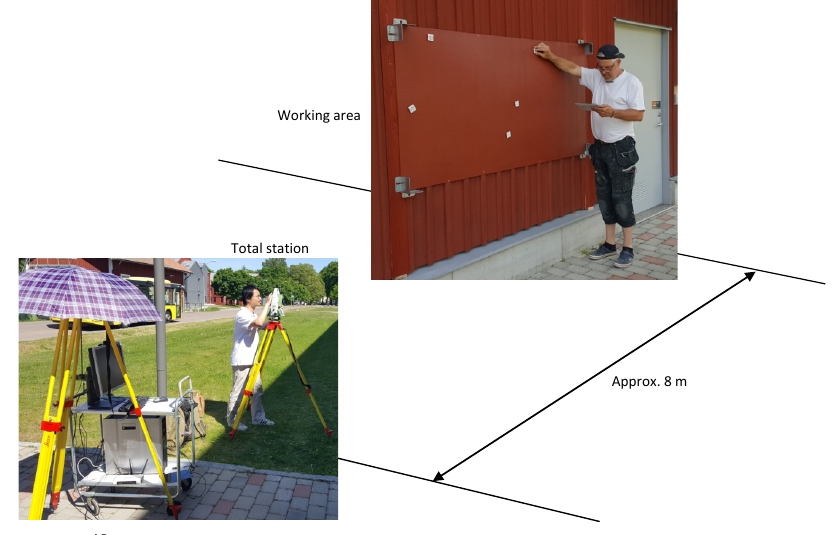
Figure 11. The user experiment environment. The AR system (Lower) is placed approximately 8 m away from the working area (Upper) and is transmitting augmented video frames (refer to Figure 4) to the tablet held by the subject for guiding marker